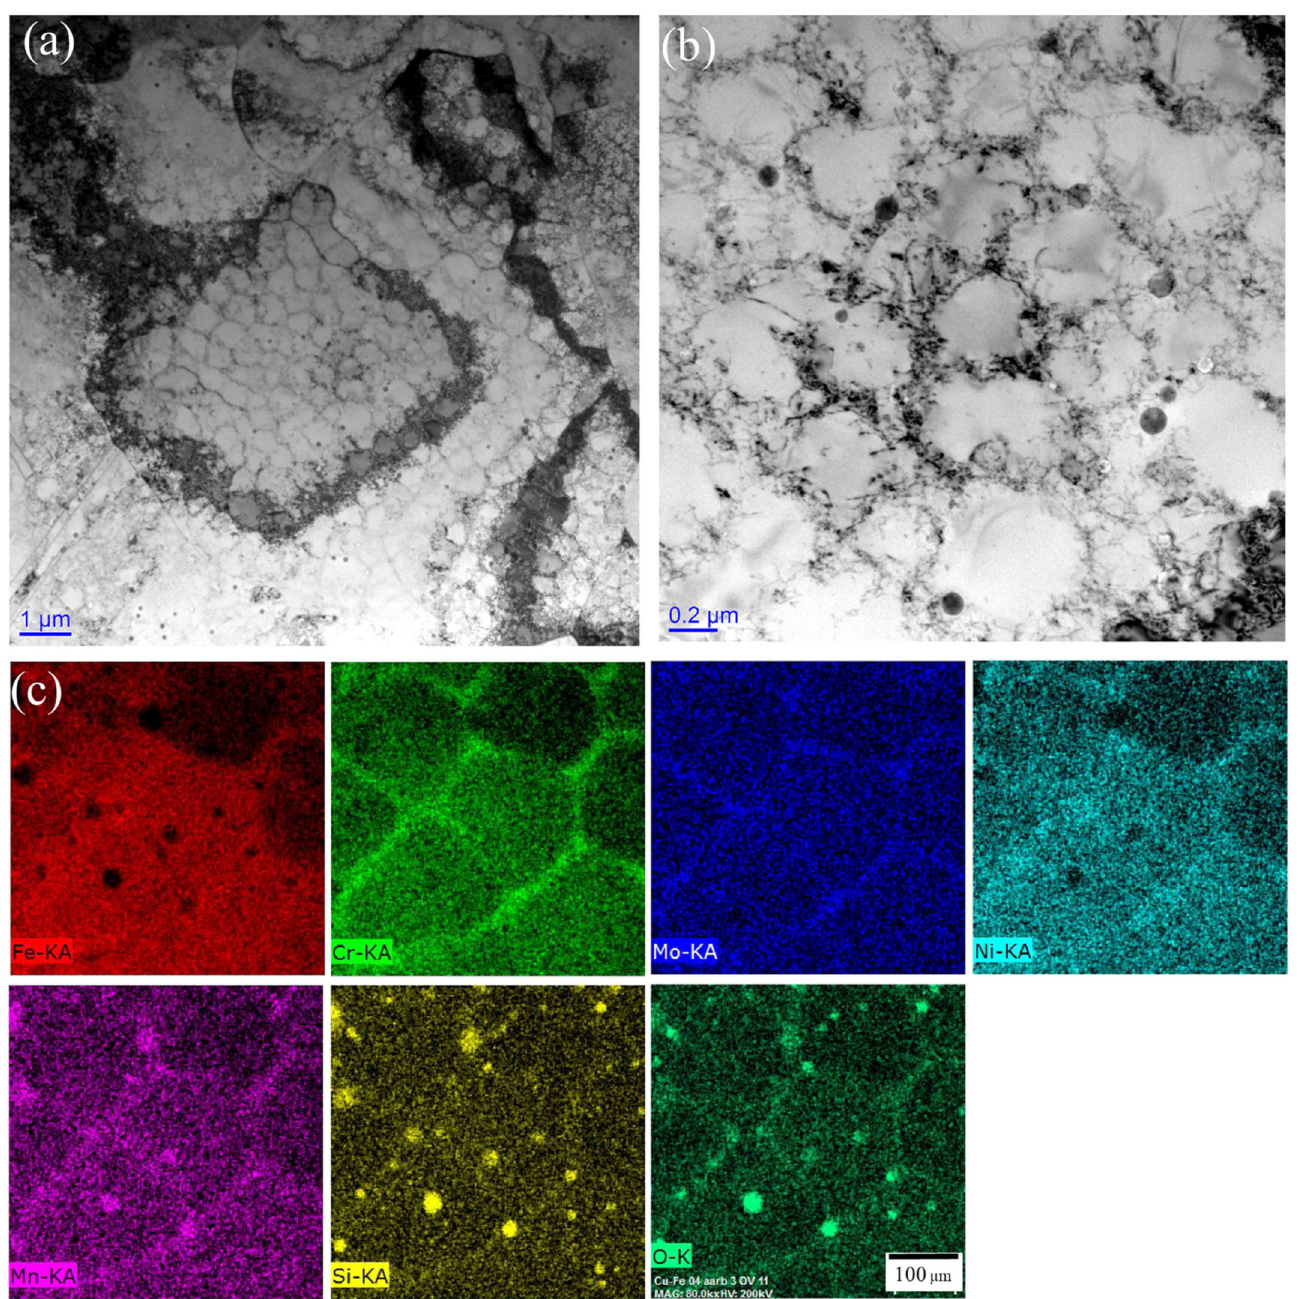
Figure 7. Transmission electron microscopy (TEM) images ( a ) low magnification, ( b ) higher magnification, and ( c ) the energy dispersive spectroscopy TEM of SLM-built 316L SS. Adapted from ref.